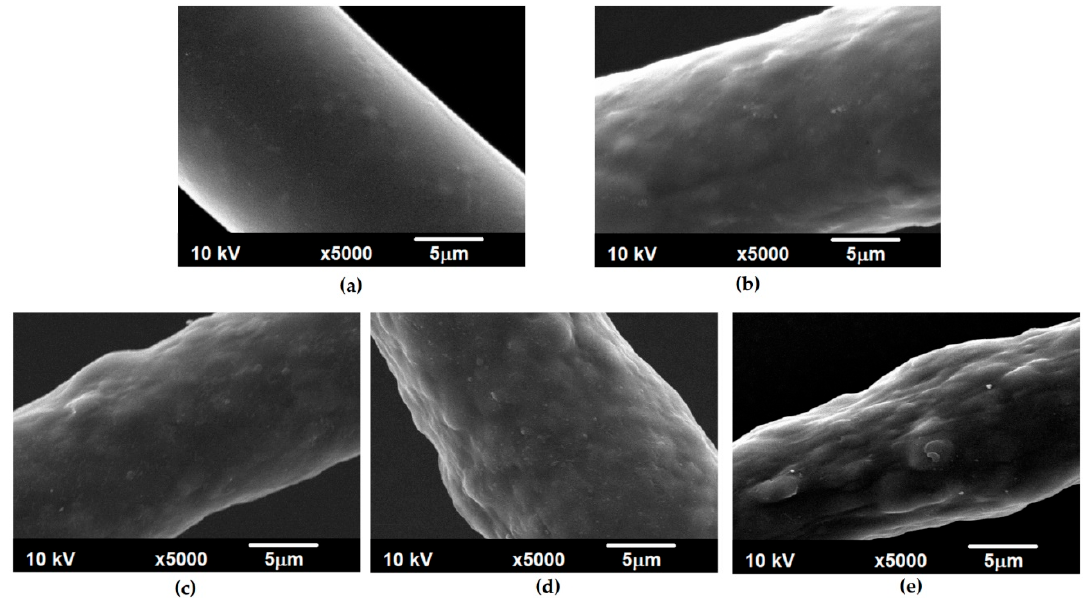
Figure 1. SEM images of the surfaces of the poly(butylene terephthalate) (PBT) fibers with different contents of reduced graphene oxide: ( a ) 0 wt %; ( b ) 0.5 wt %; ( c ) 1 wt %; ( d ) 1.5 wt %; ( e ) 2 wt % (V take-